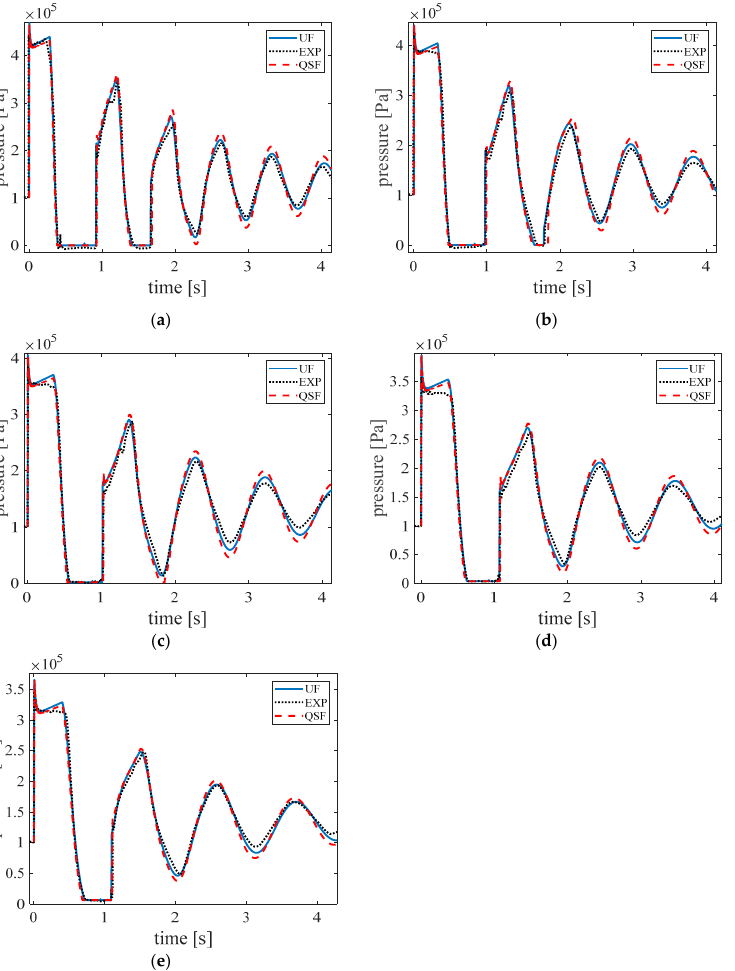
Figure 4. Computed and measured results for different cases: ( a ) Case 01 (13.8 ℃) ; ( b ) Case 02 (25 ℃) ; ( c ) Case 03 (31 ℃) ; ( d ) Case 04 (35 ℃) ; ( e ) Case 05 (38.5 ℃) .